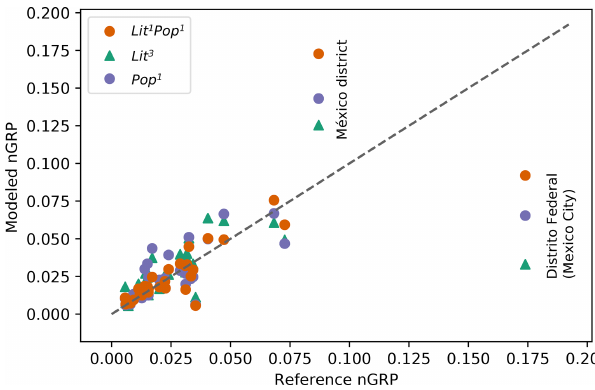
Figure 5. Normalized gross regional product (nGRP) for the 32 districts of Mexico. Reference values are shown on the horizontal axis and modeled values on the vertical